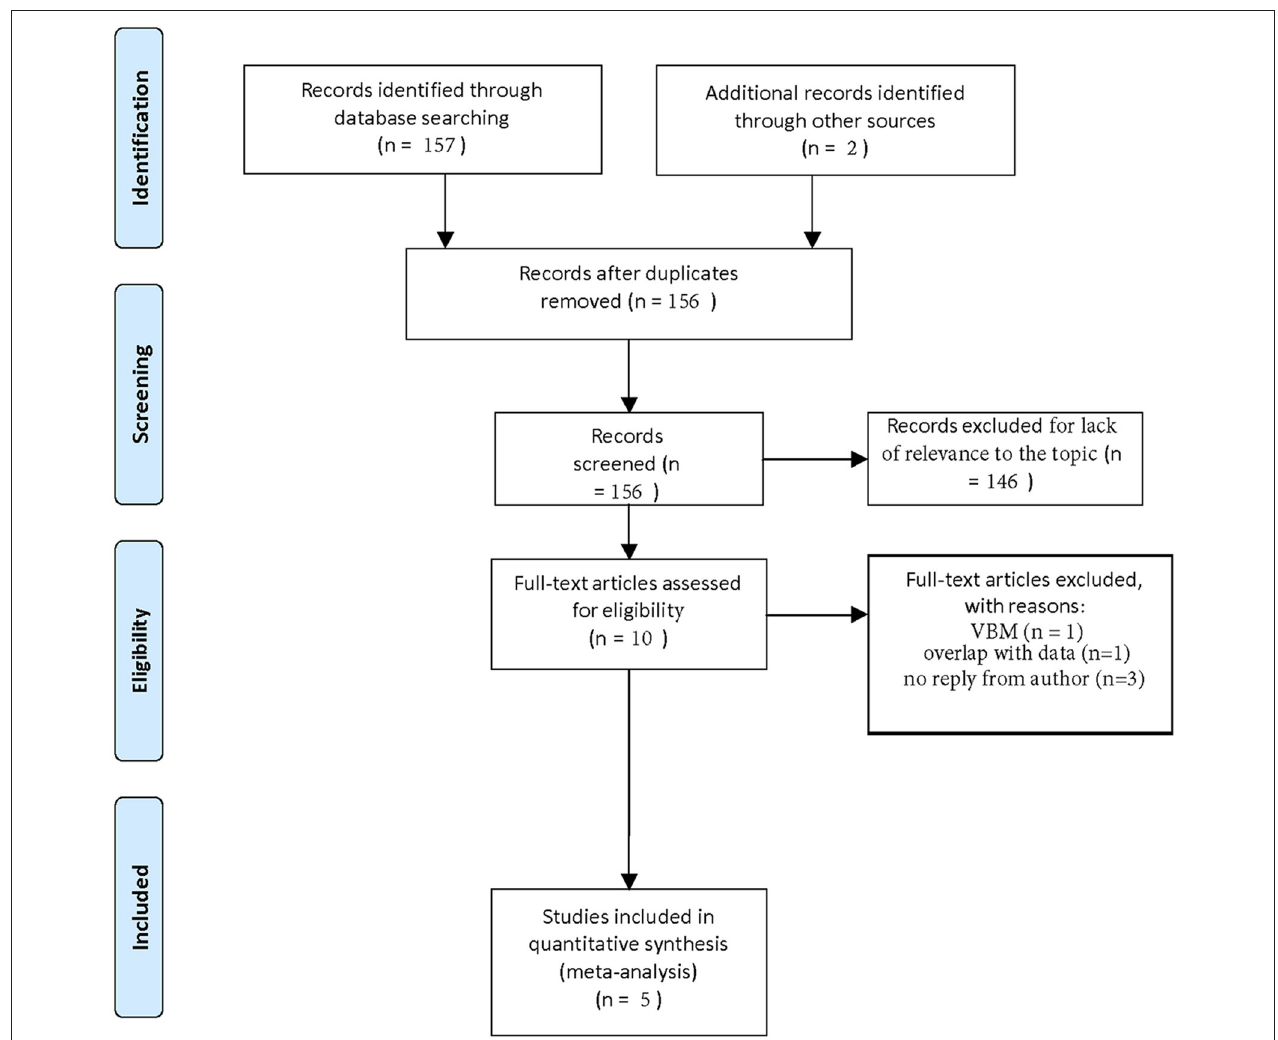
FIGURE 1 | Flow chart of selection